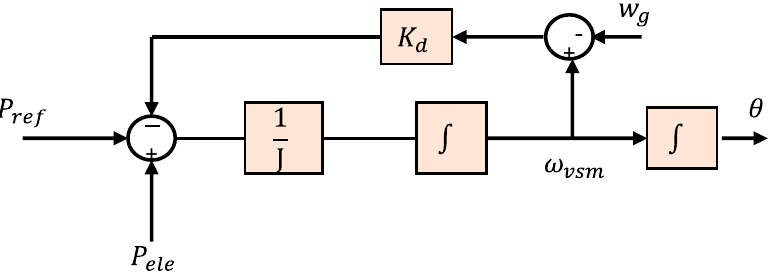
Figure 19. Model of low-order VSM.